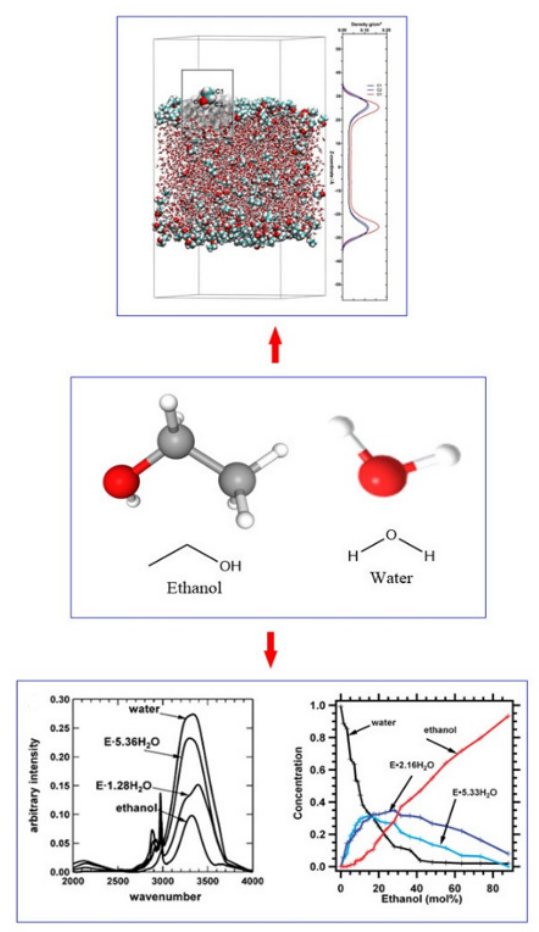
Figure 4. The hydrogen bond structure characterization of ethanol–water.Reprinted with permission from Ref. [31]. Copyright 2010, American Chemical Society; Reprinted with permission from Ref. [32]. Copyright 2017, The